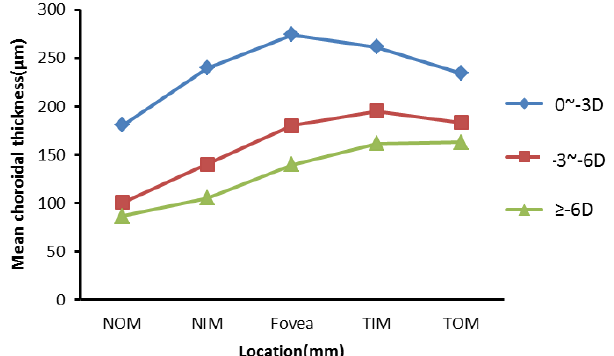
Fig. 7. The distribution of CT in fovea, temporal, and nasal of low, moderate, and high myopia. The thickest CT lies under the fovea in low myopia, and is thinnest under the nasal region. However, in moderate and high myopia the thickest CT is in the temporal zone and thinnest under the